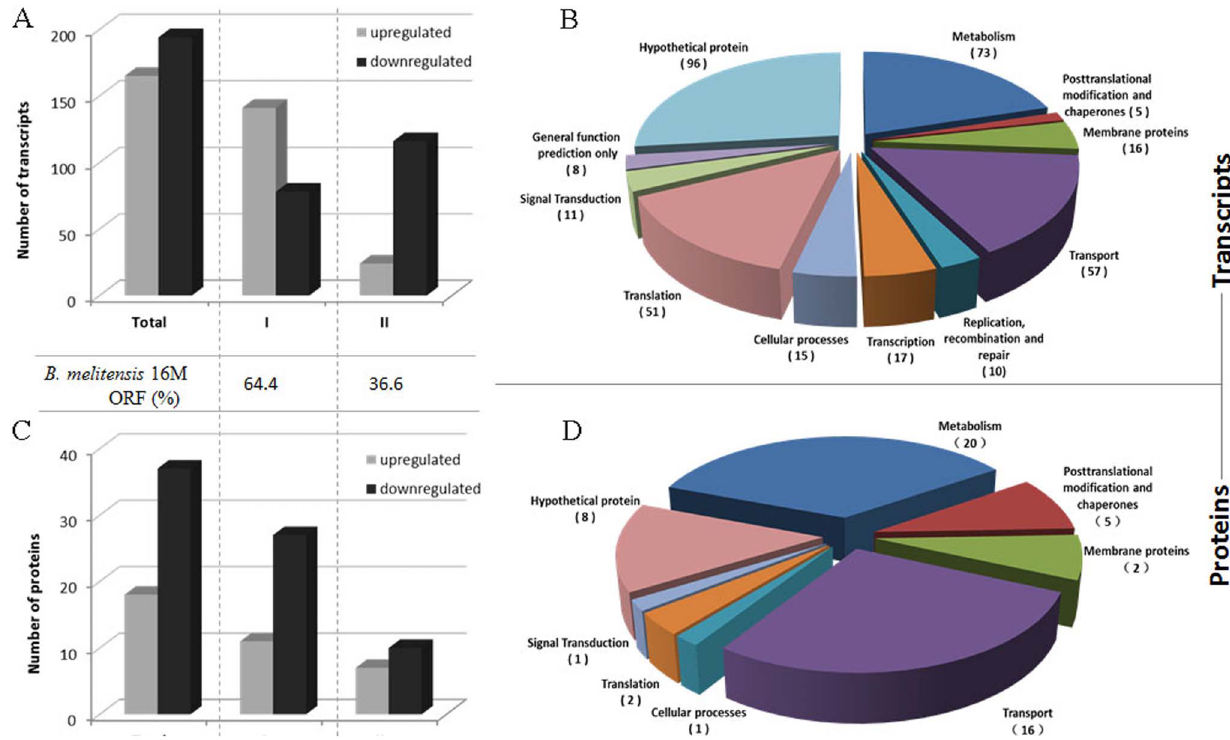
Figure 4. Differentially expressed transcripts (upper graphs) and proteins (lower graphs) in the B.melitensis D hfq mutant strain. Histograms show the number of differentially expressed genes and their distributions in the B. melitensis chromosome. The functional categories according to the B. melitensis 16 M genome sequence annotation and the KEGG database is shown to the right in circle charts. The number of genes belonging to each category are shown in brackets.